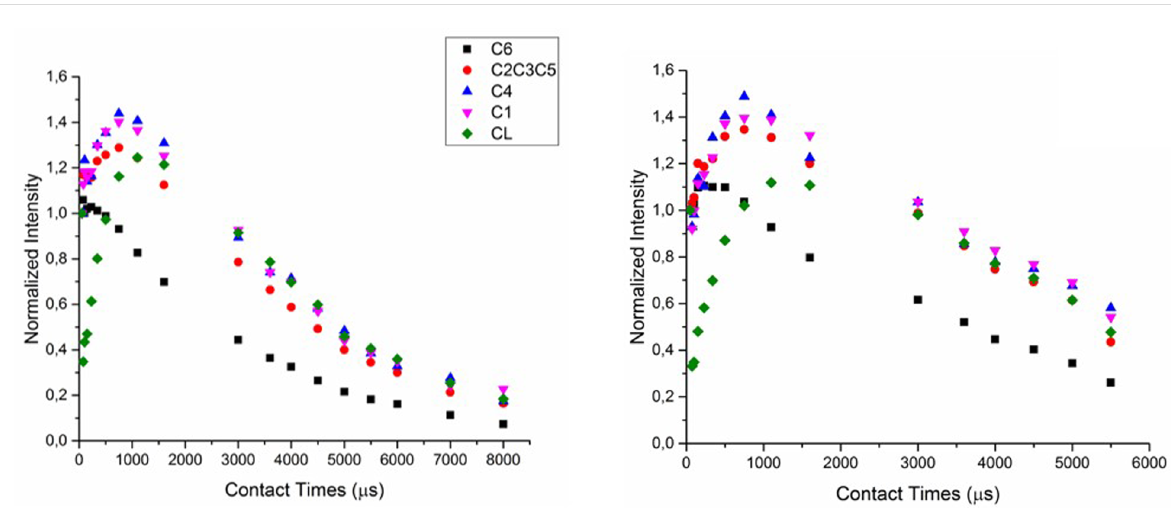
Figure 7: Time dependence of 13 C magnetization for CDNS(1:4) (left) and CDNS(1:8) (right) polymers.